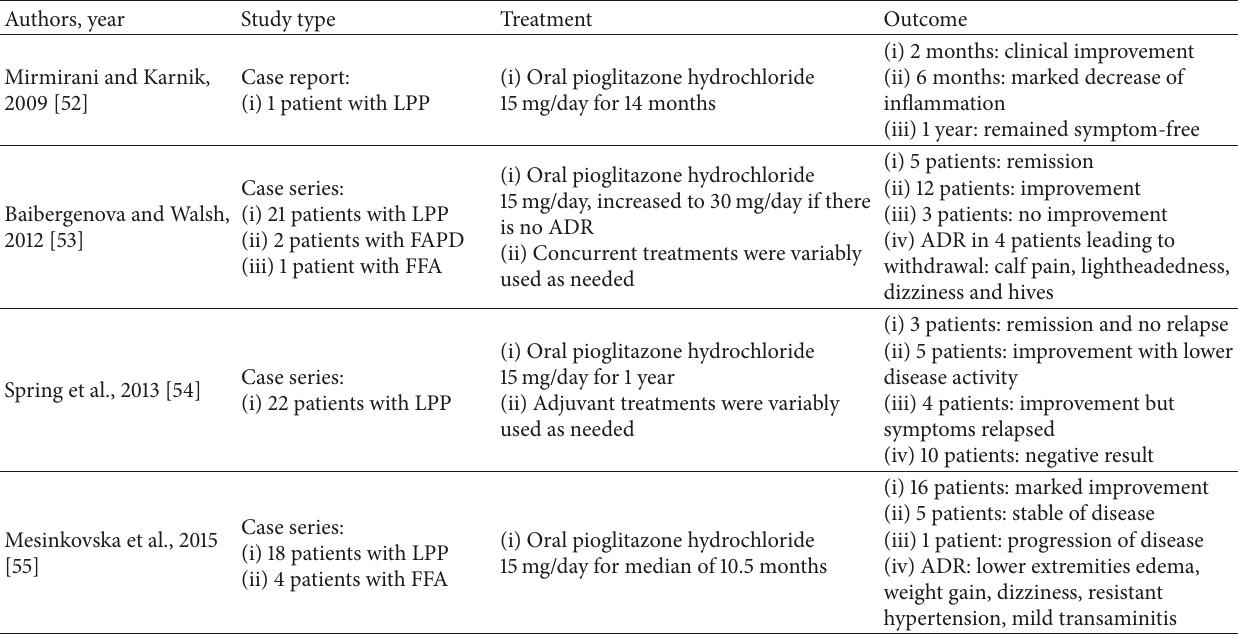
Table 3: Clinical trials of pioglitazone in the treatment of primary cicatricial